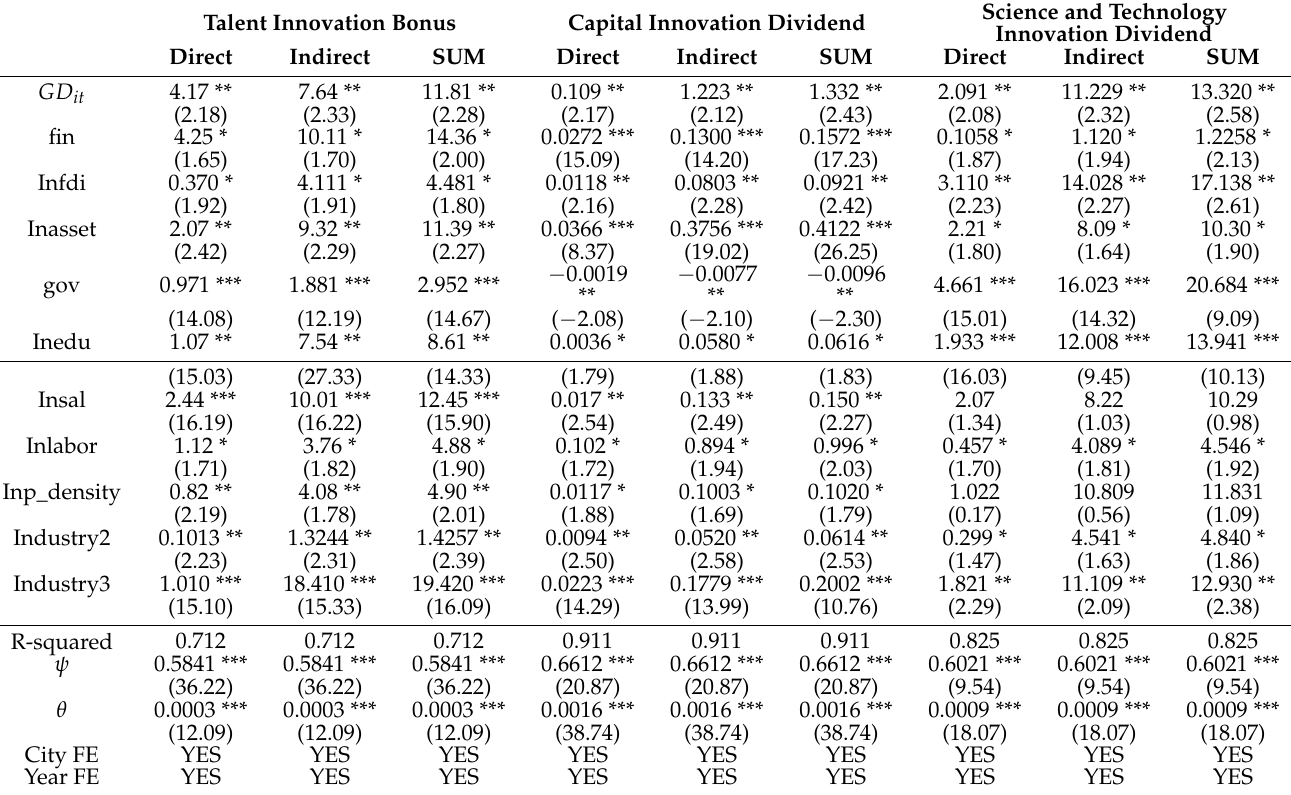
Table 11. Direct and indirect regression results of